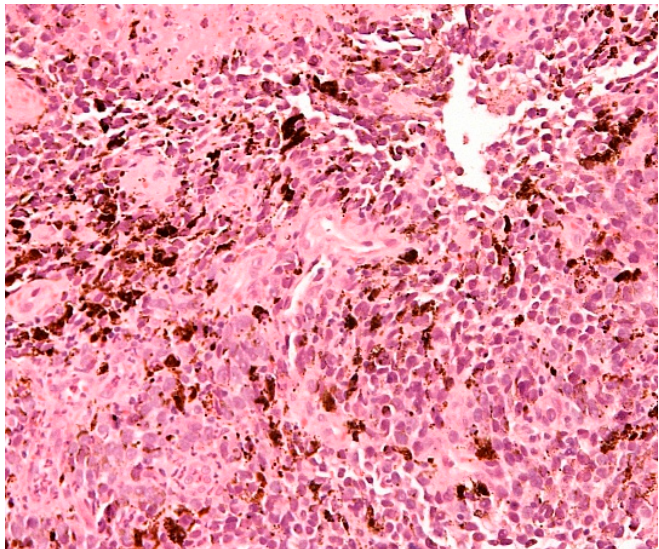
Figure 3. Biopsy specimen taken from the melanoma metastasis in the stomach presented in Figure 2. Haematoxyline-eosine staining (melanoma pigment—brown colour). Original magnification ×200.